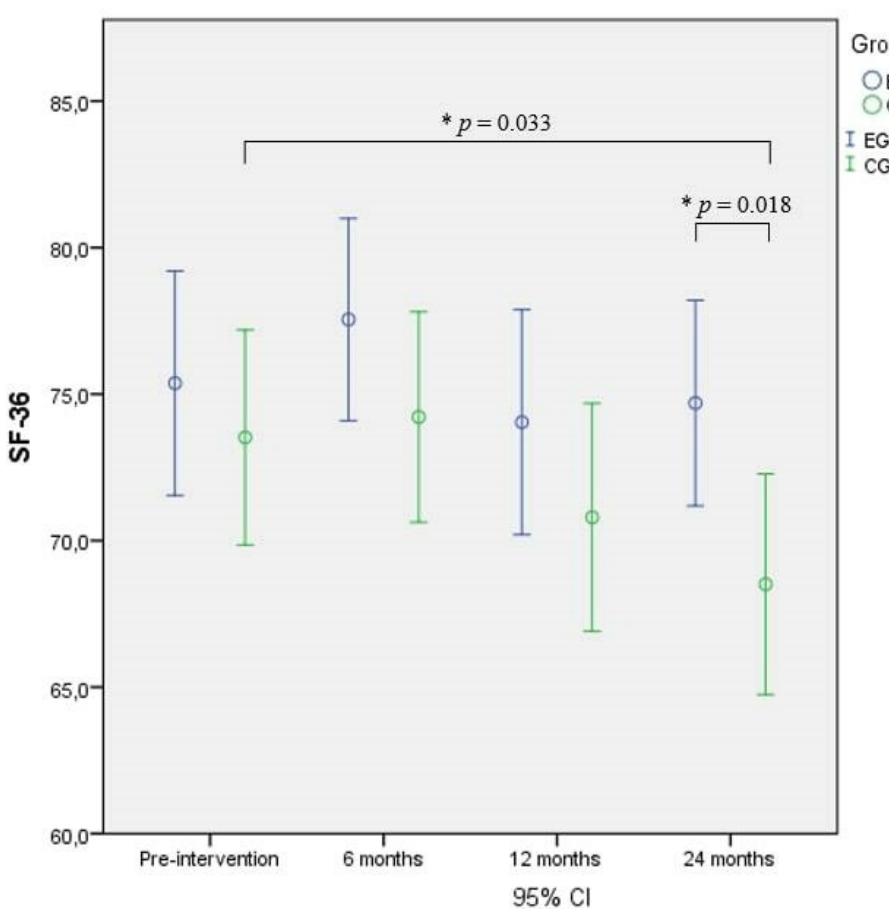
Figure 2. Short Form 36-item (SF-36) comparison between and within groups. * = Significant differ- ence.